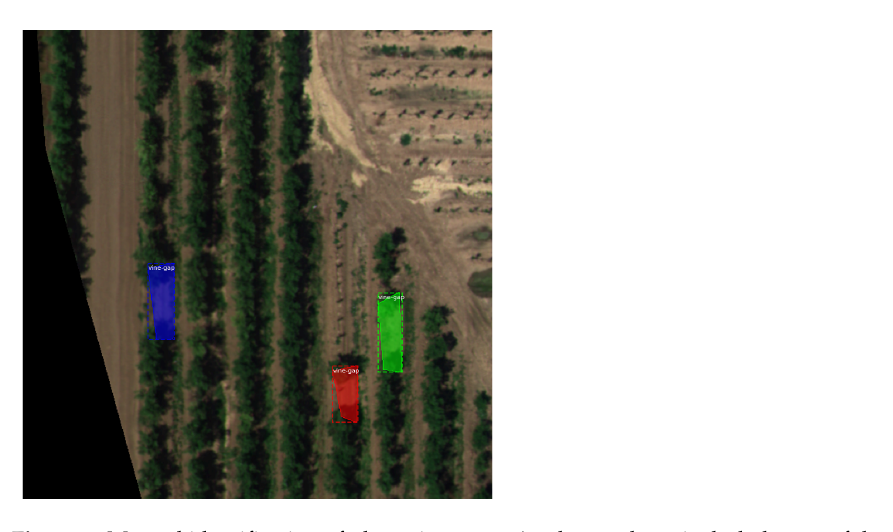
Figure 2. Manual identification of plantation gaps. As observed, we included parts of the vegetation inside the ground truth boxes (dashed line) and polygons (continuous line and colored areas). Algorithm 1 Crop images with overlap